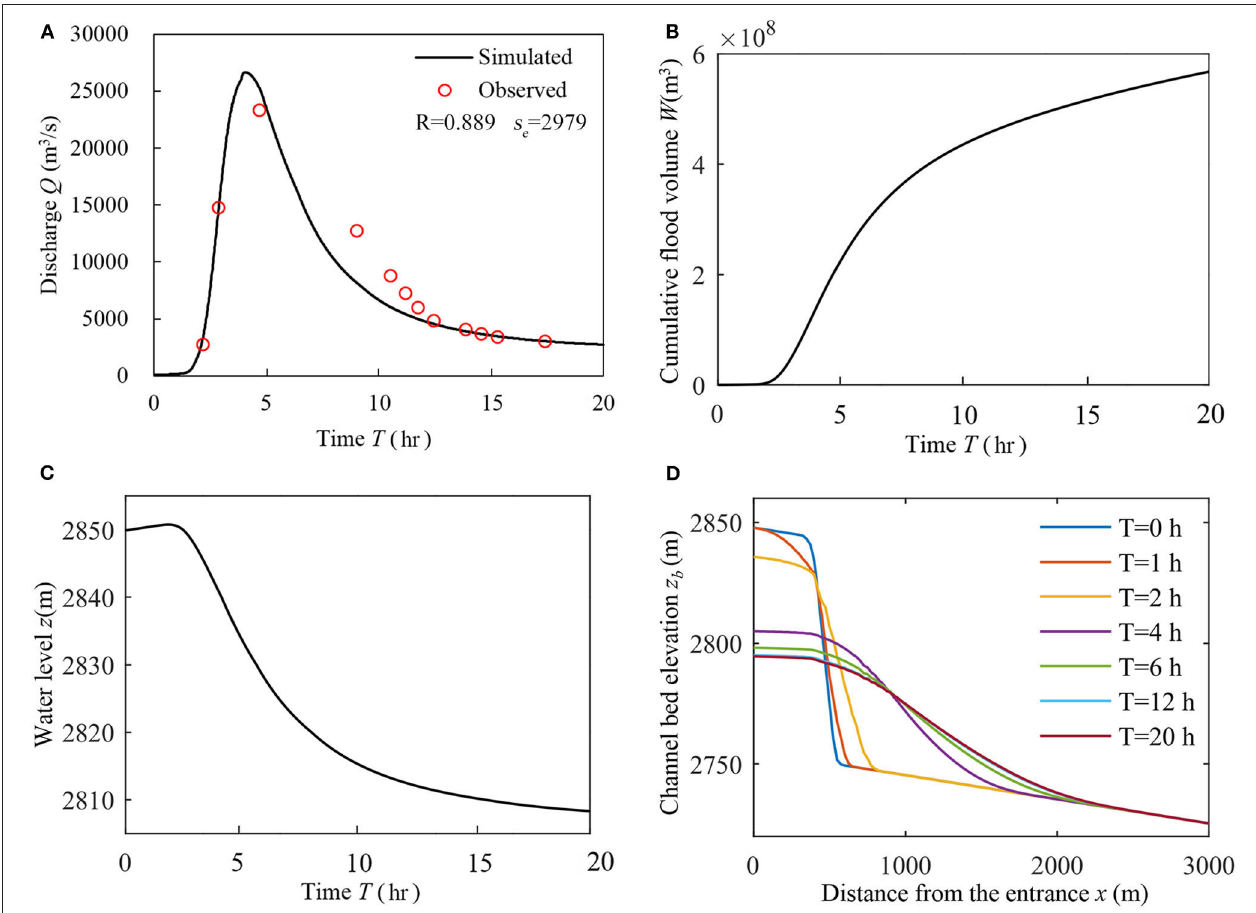
FIGURE 5 | The breach process of the “October 19” barrier lake. (A) Simulated flow hydrograph compared with the observed flow hydrograph. The Pearson correlation coefficient R is 0.889, and the root mean square error RMSE ( s e ) is 2,979; (B) simulated cumulative flood volume; (C) simulated water level at the inlet of the spillway; (D) simulated longitudinal profiles of the river channel in the computational domain.